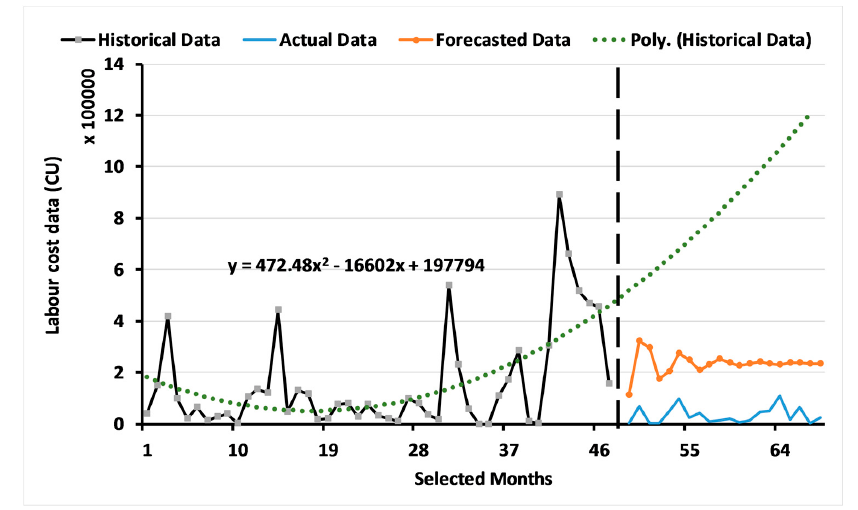
Figure 8. Labour cost data forecasting based on the dynamic regression model.